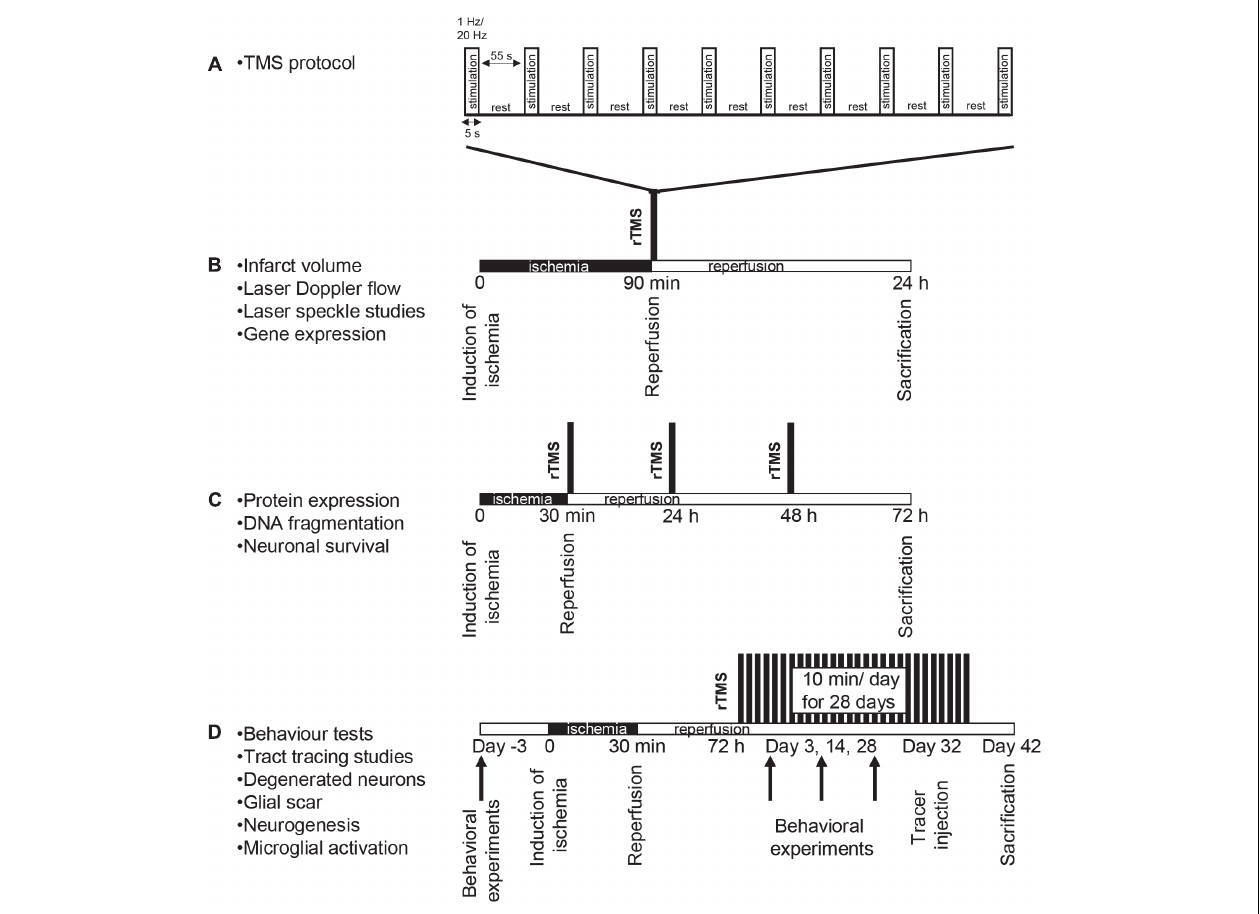
FIGURE 1 | Experimental design. Stimulation method of repetitive transcranial magnetic stimulation (rTMS) (A) and experimental protocol for 90 min ischemia 24 h reperfusion set (B) , for 30 min ischemia 72 h reperfusion set (C) and for long term set following 30 min ischemia (D) . In the first experimental setup, animals received either low-frequency (1 Hz) or high-frequency (20 Hz) rTMS for a total of 10 min with repeated 5 s stimulation and 55 s resting periods with the onset of reperfusion (A) . Control animals were placed under the rTMS coil but not subjected to stimulation. All rTMS stimulations were carried out under anesthesia and control animals received sham stimulation under